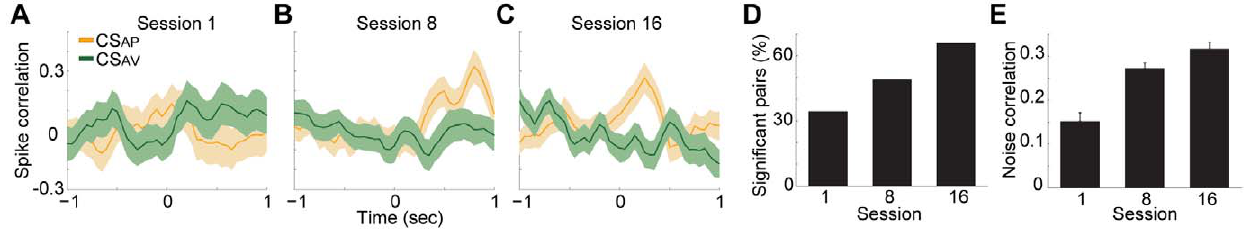
Figure 2. Correlated discharge between pairs of VTA units. ( A–C ) The normalized mean spike count correlation between pairs of simultaneously recorded units aligned to onset of either CS. Data are depicted as mean 6 SEM (solid line=mean, shaded area=SEM). Color legend for A–C appears in upper left corner of A. ( D ) The percentage of unit pairs with statistically significant noise correlations. Data are presented as the percentage of simultaneously recorded pairs of units, which had a significant correlation in the mean subtracted spike count during each session. ( E ) Magnitude of noise correlations for significant pairs during sessions 1, 8, and 16. Data are presented as the mean noise correlation + SEM between pairs of VTA units in each session.